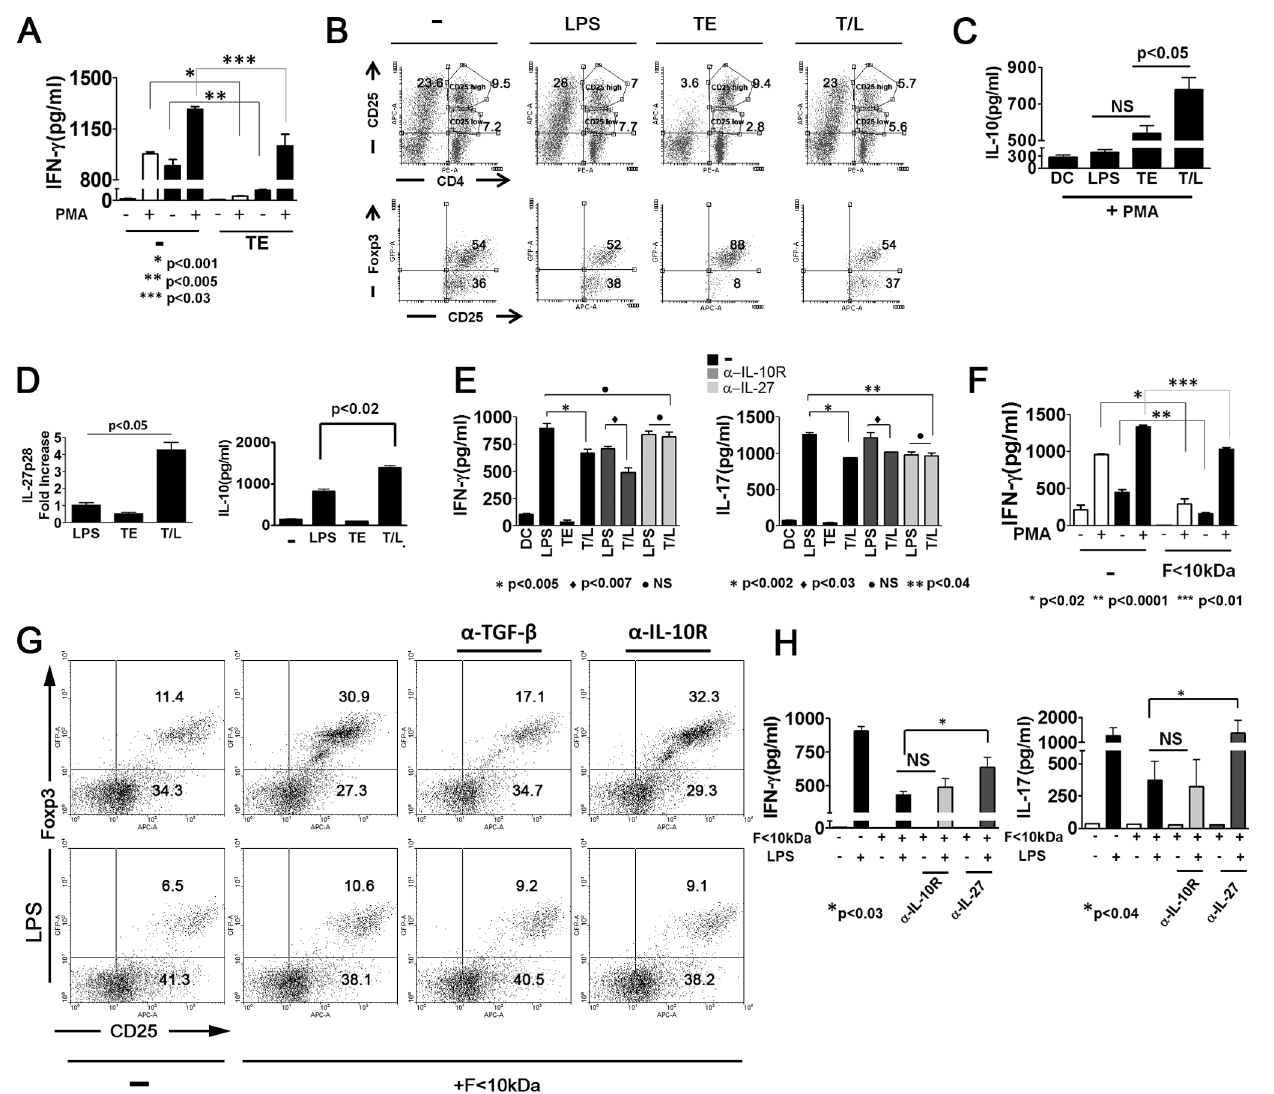
Fig. 2. Reduced capacity of TE and F , 10 KDa to prime allogeneic responses in vitro . (A) DC from BALB/c mice treated with medium, LPS (1 m g/ml), TE (80 m g/ml) or TE plus LPS for 18 h were co-cultured for 5 days with C57BL/6splenocytes at a 1:10 ratio in the presence or absence of PMA. Allogeneic response was determined by IFN- c production by ELISA. (B) DC from BALB/c mice, treated as described in A, without PMA, were cultured with a sorted EGFP negative cell population from splenocytes of Foxp3EGFP mice for 5 days. Dot plots show the CD4 vs CD25 profile of culture cells (upper panel) and the Foxp3 vs CD25 on the CD25 high gated cell population (lower panel). The numbers represent the percentage of Foxp3 positive and negative cells gated on the CD25 high cell population. (C) IL-10 was measured in the supernatant of allogeneic cultures as described in A in the presence of PMA for the last 18 h of culture, p , 0.006 versus T/L-DC (ANOVATest). (D) IL-27 mRNA was measured in DC treated with medium, LPS (1 m g/ml), TE (80 m g/ml) or TE plus LPS for 6 h by RT-PCR or IL-10 was detected in culture supernatant by ELISA after 18 h of culture, p , 0.001 versus T/L-DC (ANOVATest). (E). IFN- c or IL- 17 were detected in the supernatant of DC from BALB/c mice treated with medium, LPS, TE or TE plus LPS for 18 h, and cultured with splenocytes from C57BL/6 at a 1:10 ratio for 5 days in the presence or absence of anti IL-10 R, anti-IL-27 or the control isotype Abs. Data are representative of three experiments, with p representing a significant difference in the Student’s t-test. (F) IFN- c was measured by ELISA in culture supernatants of splenocytes (C57BL/6) and DC (BALB/c mice), previously pulsed for 18 h with medium, or F , 10 kDa (20 m g/ml) in the presence or absence of LPS (1 m g/ml) for 5 days. On day 4, the cells were stimulated with PMA for the last 18 h. (G) DC from BALB/c mice treated with medium or F , 10 kDa (20 m g/ml) for 18 h were cultured with a sorted EGFP negative cell population from splenocytes of Foxp3EGFP in the presence or absence of anti- TGF b or anti IL-10R for 5 days. Dot plots show the Foxp3 vs CD25 profile of splenocytes gated on the CD4 population. (H) IFN- c and IL-17 were detected in the supernatant of cultures as described in F, in the presence or absence of anti IL-27 or anti IL-10R blocking Abs. Data are representative of 2 experiments with similar results. The bar graphs shown one experiment representative of three with the mean ¡ SD. p represents a significant difference in the Student’s t-test.